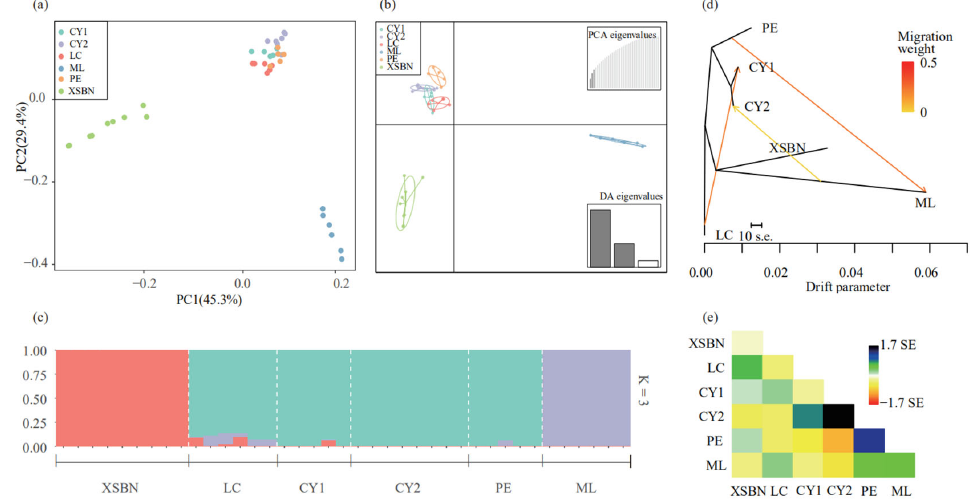
Figure 5. ( a ) Principal components analysis (PCA) plot generated for T. doichangensis . ( b ) Discriminant analysis of principal components (DAPC) plot generated for T. doichangensis . ( c ) Genetic structure bar plots at K = 3 from clustering analysis among six populations using Admixture. ( d ) Unrooted maximum likelihood phylogenies from ten iterations of three migration events. The variance of relatedness explained by this model was estimated to be 99.98%. The line represents gene flow; the direction of the arrow is the direction of gene flow; the color bar shows the migration weight, with red representing strong gene flow and yellow representing weak gene flow. The direction of gene flow was PE into ML, LC into CY1 and ML into CY2. ( e ) Residuals matrix for migration model.